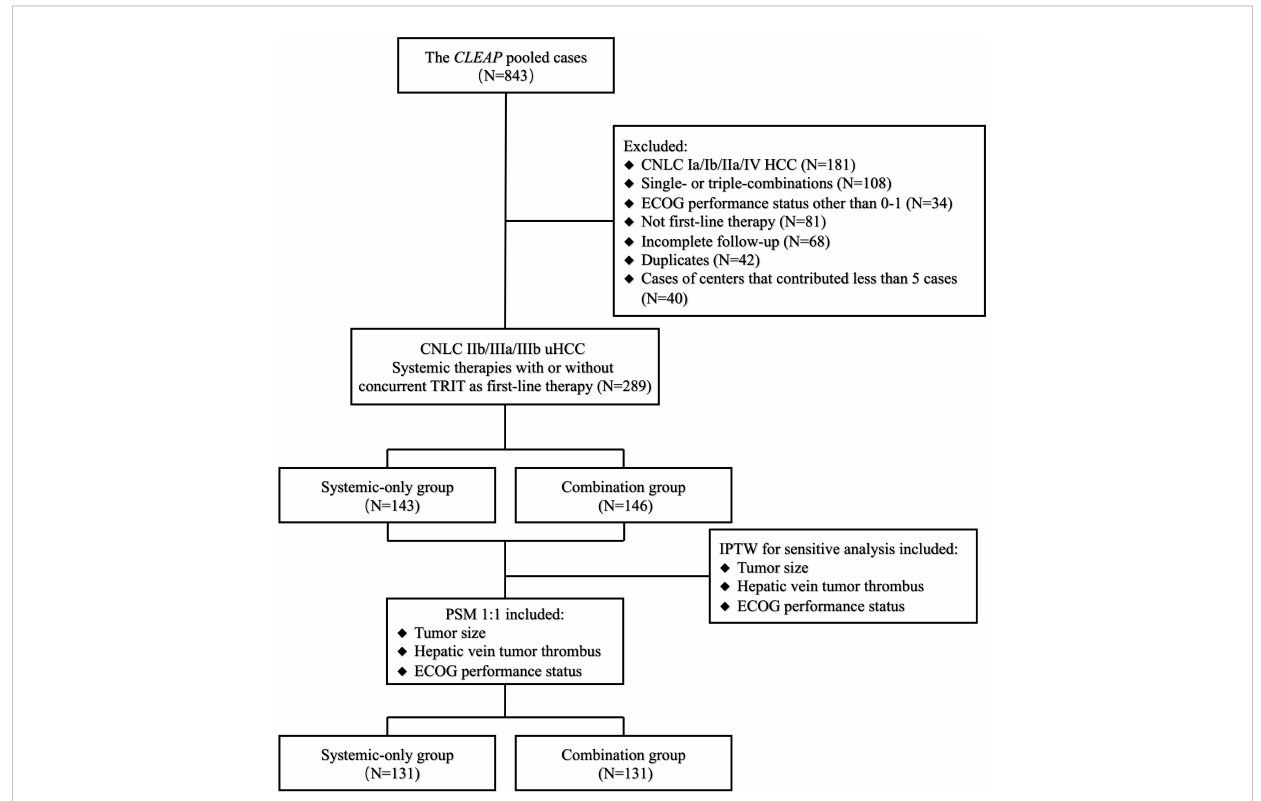
FIGURE 1 Patient disposition. CLEAP, China Liver Cancer Study Group Young Investigators; CNLC, China liver cancer; ECOG, Eastern Cooperative Oncology Group; uHCC, unresectable hepatocellular carcinoma; PSM, propensity score matching; IPTW, inverse probability of treatment